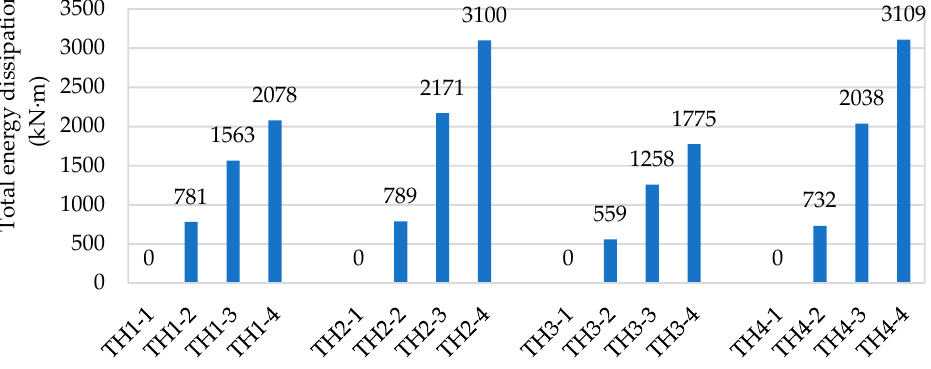
Figure 14. Energy dissipation distributions under ( a ) GM 1; ( b ) GM 2; ( c ) GM 3; and ( d ) GM 4.